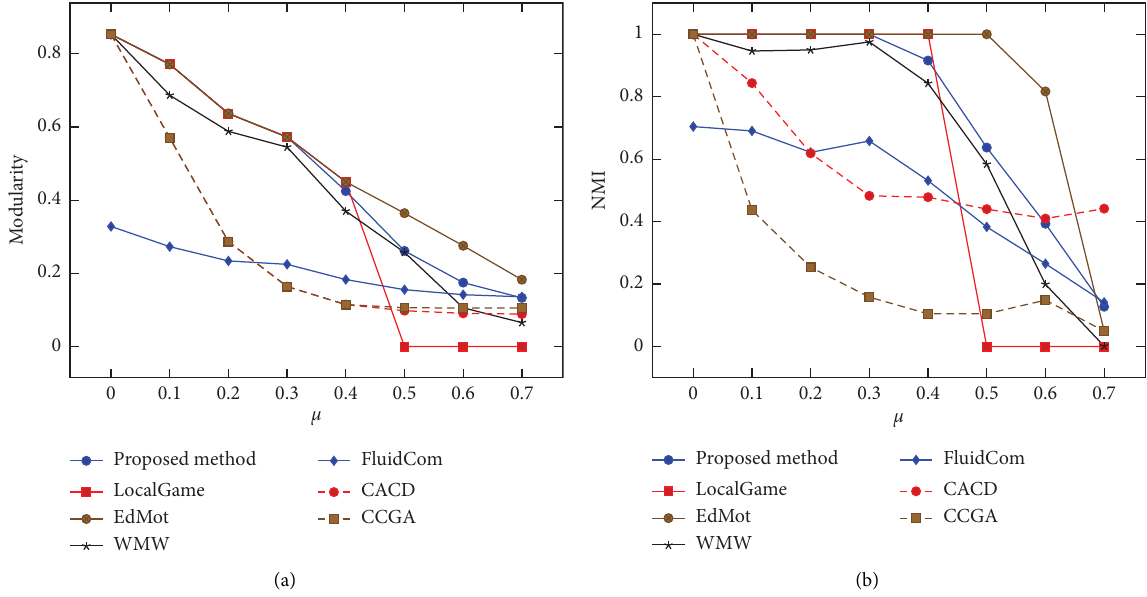
Figure 6: Comparison of the results of the proposed method with some of the recent community detection algorithms based on their response to diferent μ values of LFR networks. (a) Comparison of modularity value for LFR- μ dataset, (b) Comparison of NMI value for LFR- μ